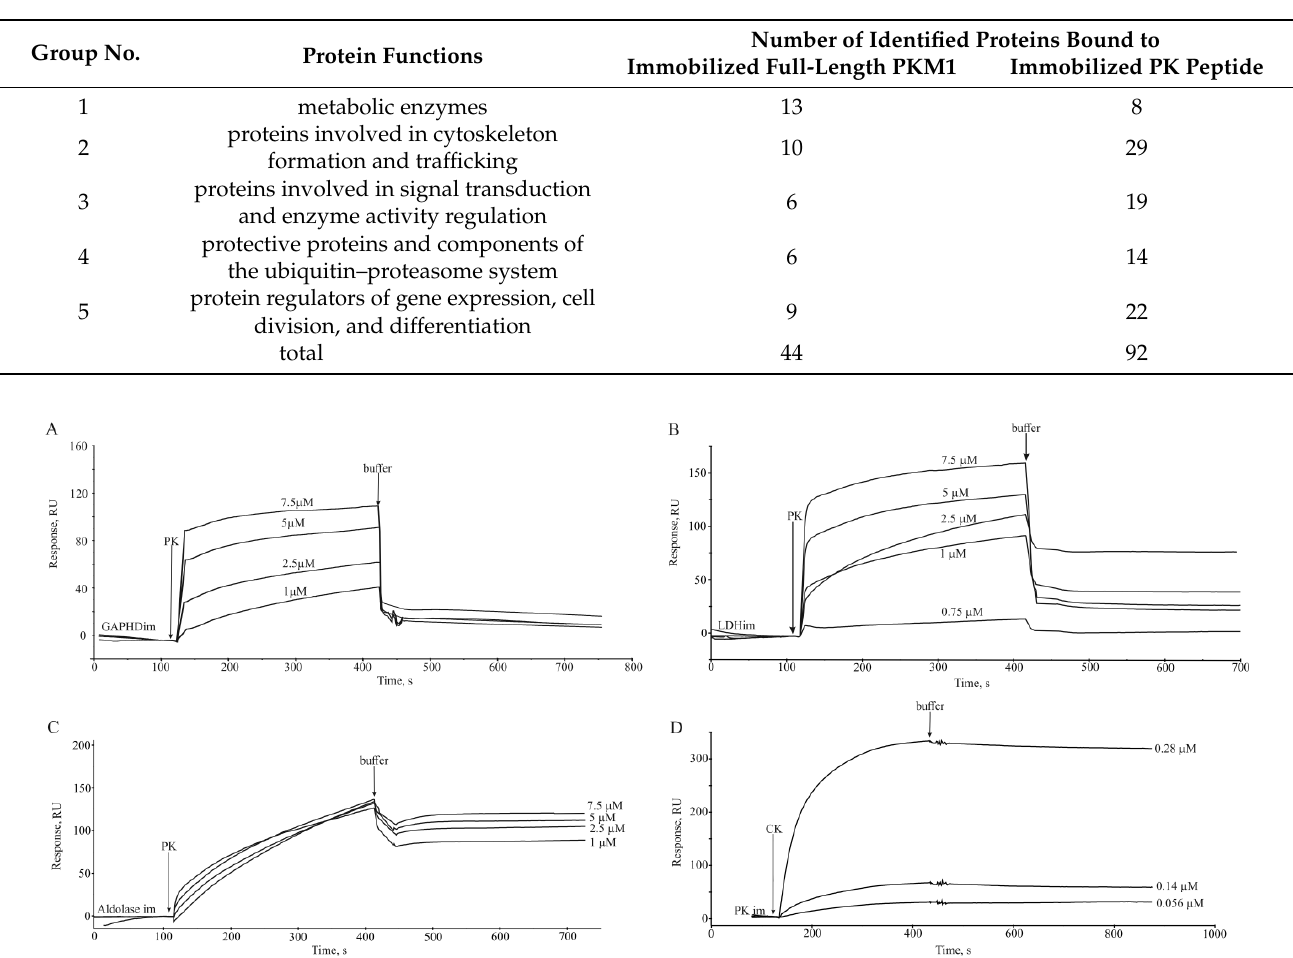
Table 1. Distribution of the identified mouse brain proteins among functional groups.